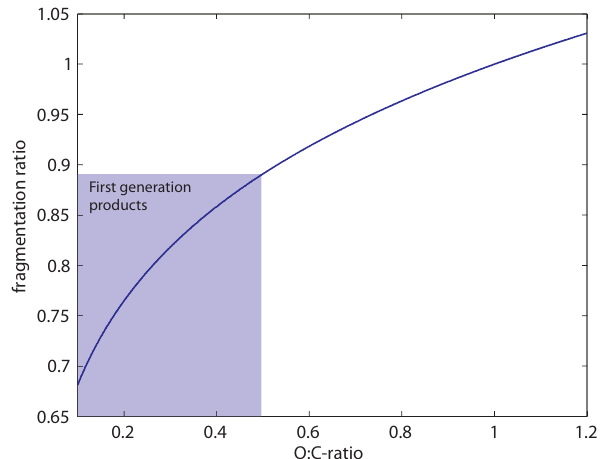
Figure A1. Fraction of products that undergo fragmentation in the 2DVBS scheme as a function of their O:C ratio. The shaded area shows the range of O:C ratio of the first-generation products in the